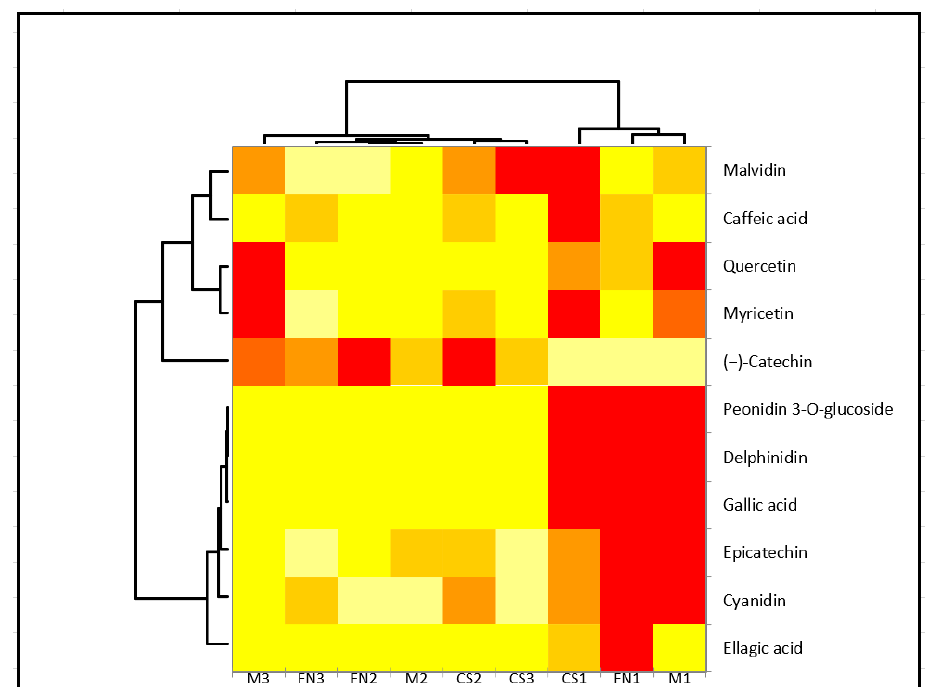
Figure 3. Heatmap of quantified polyphenolic compounds based on variety. Clustering between variety and also polyphenols was selected. The correlation is colored in shades of yellow (low correlation) to red (high correlation). Sample code designation was conducted according to area and vintage: Murfatlar 2014—FN1, CS1 and M1; Murfatlar 2015—FN2, CS2 and M2; and Valea Calugareasca 2015—FN3, CS3 and M3.